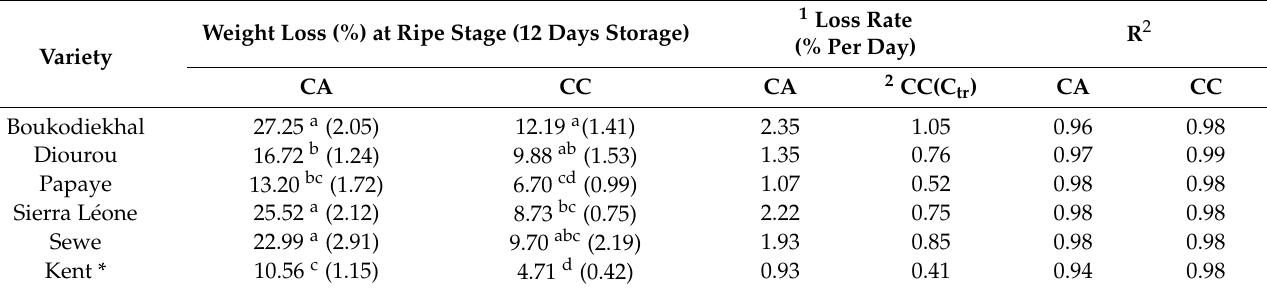
Table 2. Percentage of weight lost at 12 days (ripe stage), loss rate (slope in %/day) and linear regression coefficient (R 2 ) as a function of variety and storage conditions (AC: ambient; CC: controlled 25 ◦ C/86%